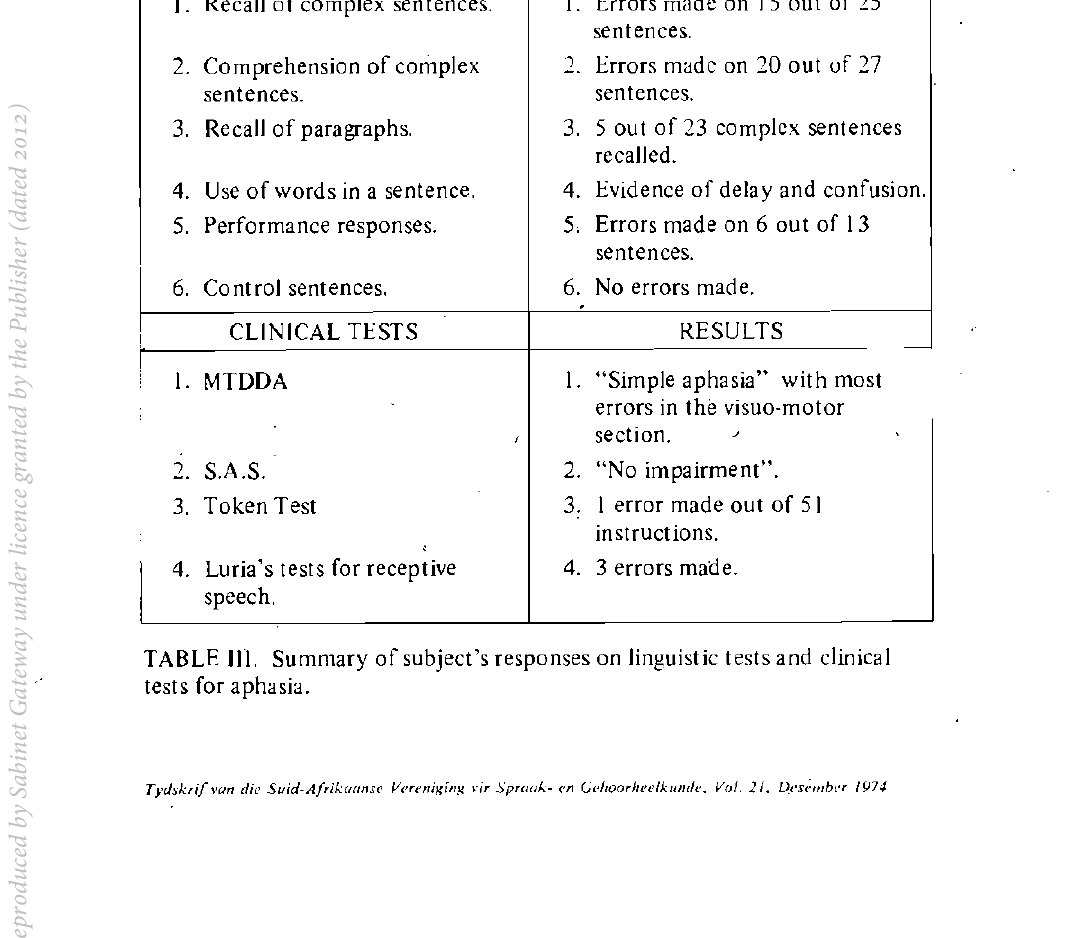
Tydskrif van die Suid-Afrikaanse